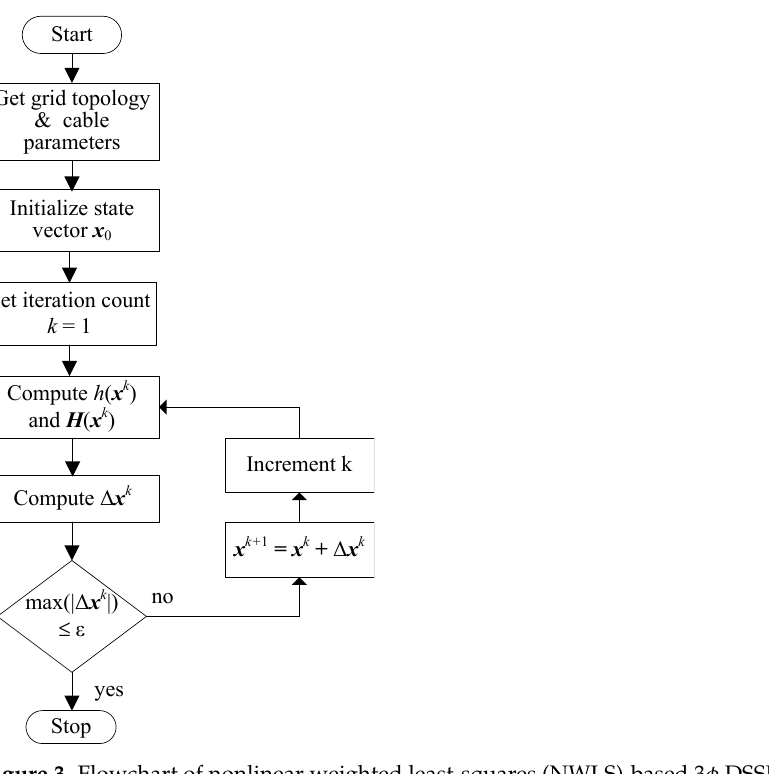
Figure 3. Flowchart of nonlinear weighted least-squares (NWLS)-based 3 φ DSSE